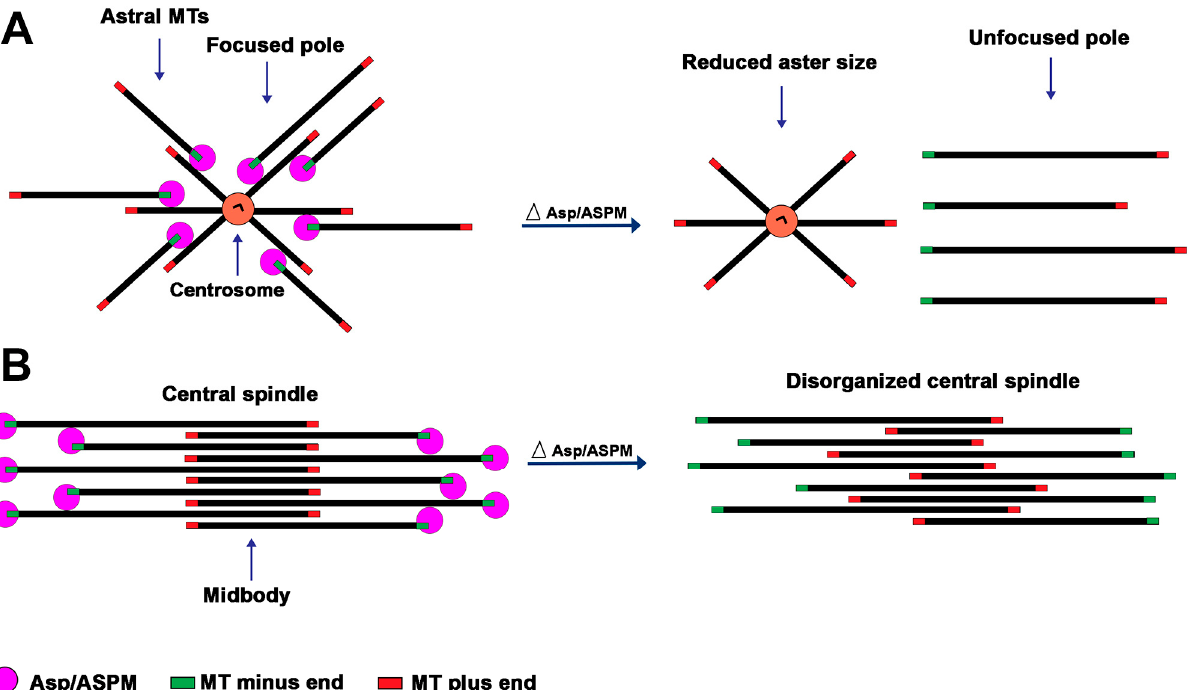
Figure 2. Model for the Asp/ASPM function at the asters/spindle poles and the telophase central spindle. The model has been elaborated based on both the Asp/ASPM localization studies and the phenotypic analyses of the consequences of Asp/ASPM deficiency. ( A ) At the spindle poles, Asp/ASPM binds the MT minus ends, mediating both inter se minus end association (not depicted) and minus end crosslinking to the sides of the MTs attached to the centrosomes, thereby ensuring both spindle pole focusing and astral MT stability. In Asp/ASPM deficient cells, the MTs would be normally nucleated by the centrosome but would not be held in its vicinity after their release from this organelle, leading to reduced aster size, unfocused spindle poles, and centrosome detachment. ( B ) In the central spindle, Asp/ASPM binds the MT minus ends mediating both inter se minus end association (not depicted) and minus end crosslinking to the sides of the other MTs of the bundle, thereby stabilizing the central spindle structure. In the absence of Asp/ASPM, the central spindle MTs would slide along each other, disrupting proper MT plus end overlapping at the midbody, leading to defective contractile ring formation and positioning and cytokinesis failure. 4.4. The Roles of Asp/ASPM Orthologues in the Orientation of Mitotic Divisions In both Drosophila and mammals, spindle orientation plays a critical role in neuro- genesis. During early neurogenesis, neural progenitor cells (NPCs) undergo a series of symmetric divisions (with the spindle axis parallel to the neuroepithelium plane), thereby expanding the NPC pool. After increasing their number, NPCs divide asymmetrically (with the spindle axis oblique/orthogonal to the neuroepithelium plane), generating an- other NPC and a cell that will differentiate into a neuron. Defects in spindle orientation and cell cycle/mitotic delays can result in premature differentiation leading to a reduction in the final neuron number and in brain size [56]. Many studies have shown that astral MTs play a fundamental role in spindle orientation [57–59]. Consistent with these studies, the Asp orthologous proteins have been implicated in spindle orientation. A first analysis of the role of Asp/ASPM proteins in spindle orientation has been performed on mouse NE cells. Upon RNAi-mediated Aspm knockdown, the spindle axes of NE cells were parallel to the surface of the neuroepithelium less frequently than in the wild type, indicating a precocious switch from proliferative to neurogenic divisions, accompanied by a reduction of the expansion of the NE progenitor pool [32]. This suggested that a deviation of the spindle axis in NE cells could be one of the factors leading to ASPM -dependent human microcephaly [32]. However, in a subsequent study from the same group, two mutations leading to truncated Aspm proteins (one missing exons 1–7 and the other only the C